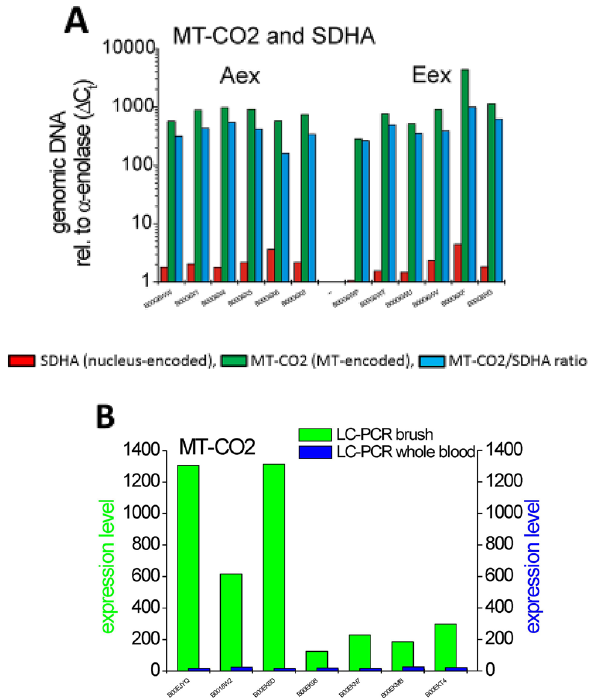
Figure 4. Molecular analysis of MT-CO2 in COPD sub-phenotypes. ( A ) Using genomic DNA for PCR, data of tested gene (MT-CO2 and SDHA) and housekeeping gene (alpha-enolase) were processed with the same settings (e.g. same thresholds). Cycle number of the housekeeping gene was subtracted from the corresponding gene and its absolute value was subsequently calculated to the power of 2. c t = cycle number at threshold; MT-CO2/SDHA ratio Aex versus Eex p = 0.33 (Mann Whitney U-Test). The average level for MT-CO2 transcripts was 8255 ± 2938 cpm for Aex samples and 30,902 ± 10,200 cpm for Eex samples ( B ) MT-CO2 expression levels were determined by RT-PCR using primers given in Table S7 on brush samples and on whole blood samples from the same individuals. Expression levels were normalized to the levels of alpha-enolase. Samples 1–4 are Eex cases, samples 5–7 are Aex